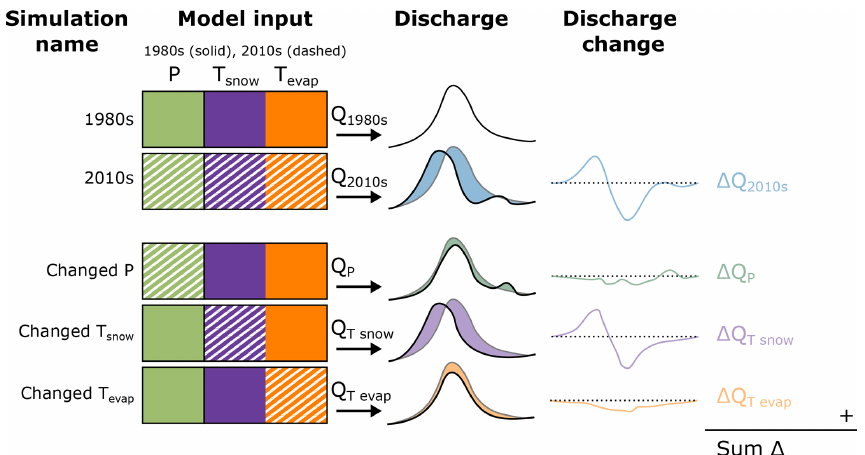
Figure 2. Conceptualization of the forcing swap experiment, showing the different simulations (rows) and steps in the analysis (columns). The different forcing variables are visualized as coloured blocks, where the solid and dashed boxes indicate forcing data from the 1980s and the 2010s,